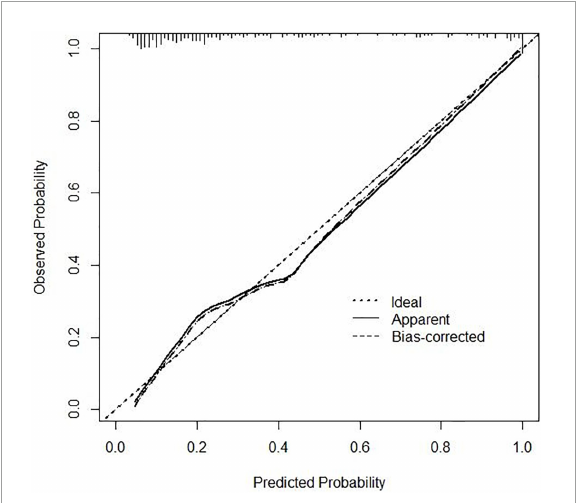
FIGURE4 Calibration curve of the nomogram. The x -axis represents the nomogram–predicted risk and the y -axis represents the actual risk of 6-month unfavorable outcome. The 45 ◦ dashed line is a reference line that shows perfect prediction. The dotted line is the performance of the nomogram, while the solid line corrects for any bias in the nomogram.